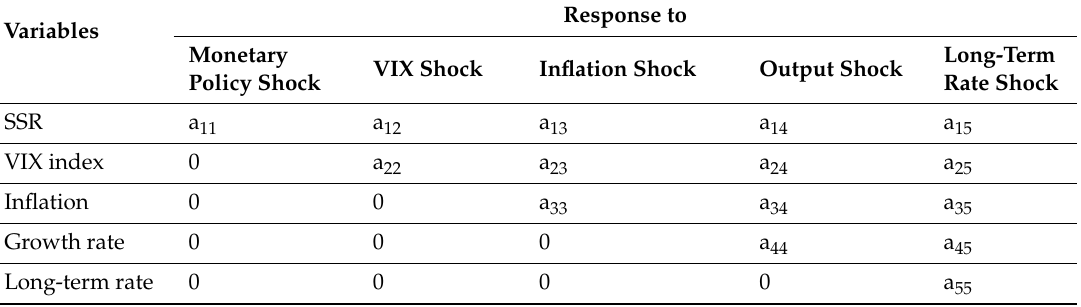
Table 2. Identifying restrictions-benchmark